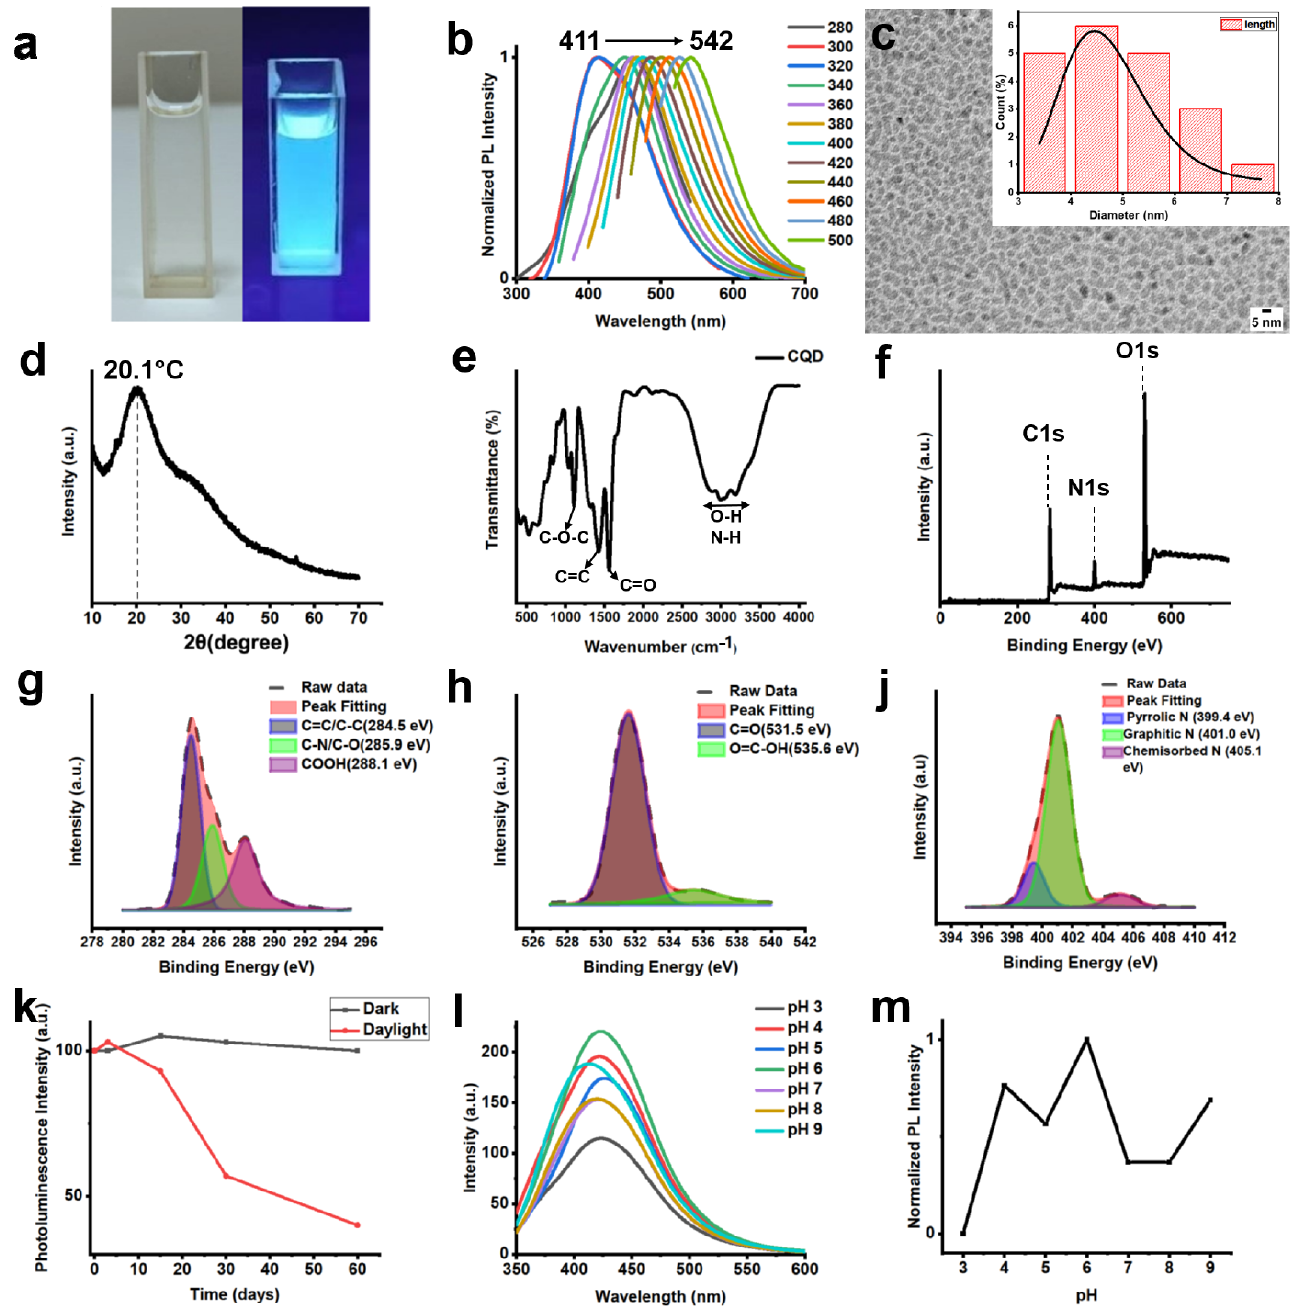
Figure 4. Further characterization of CQDs through various methods. Optic images of CQD suspension under daylight and a 365-nm UV-lamb ( a ), normalized fluorescence spectra at optimum synthesis conditions under different excitation wavelengths ( b ), representative TEM image and particles size distribution ( c ), XRD spectra ( d ), FT-IR spectra ( e ), XPS survey spectra and elemental ratio ( f ), high-resolution C1s spectra ( g ), O1s spectra ( h ), N1s spectra ( j ), the change of fluorescence intensity (ex: 320 nm) of CQDs stored under daylight and dark conditions ( k ), the fluorescence spectra at different pH values ( l ), and relevant normalized PL intensity ( m ).